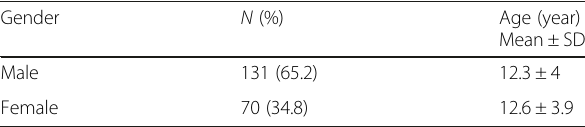
Table 1 Gender distribution of